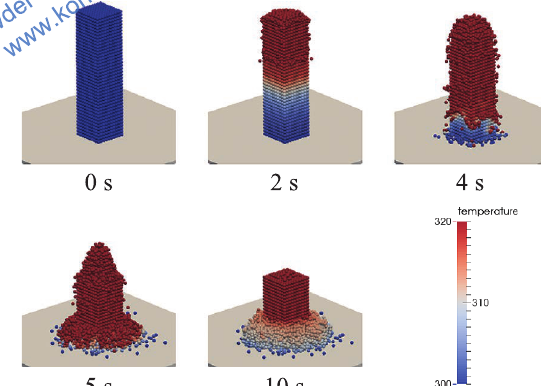
Fig. 11 Snapshots obtained from a phase change simulation (Takabatake et al., 2016) Copyright: (2016) Elsevier